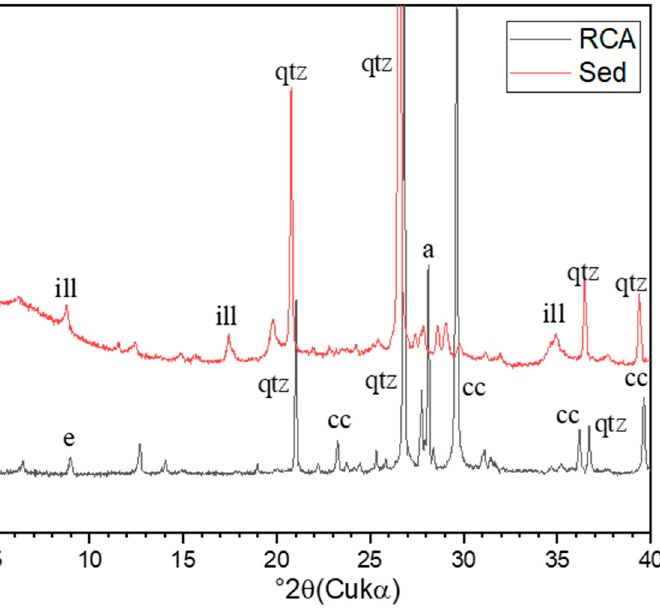
Figure 2. XRD patterns of RCAs and SEDs; qtz, quartz; cc, calcite; e, ettringite; a, albite; ill, illite .